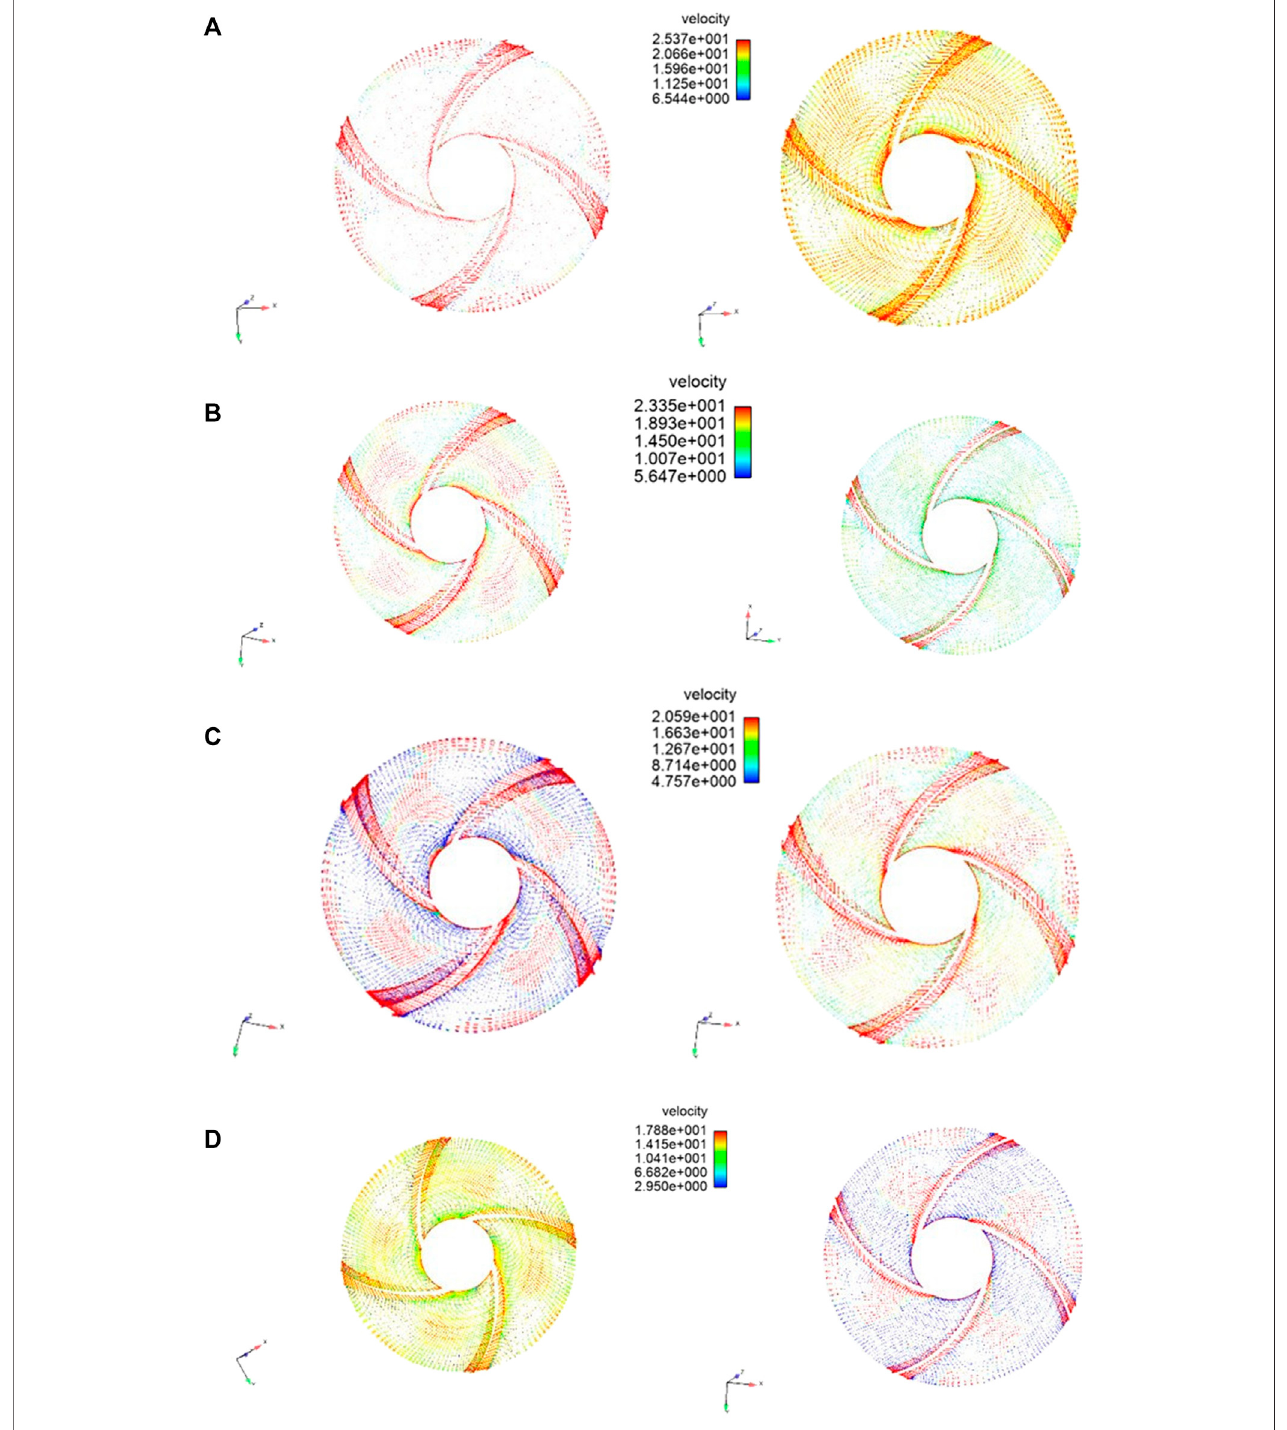
FIGURE 4 | Flow velocity vector diagrams of the impeller section: (A) 1,100 rpm, (B) 1,200 rpm, (C) 1,300 rpm, and (D) 1,450 rpm.